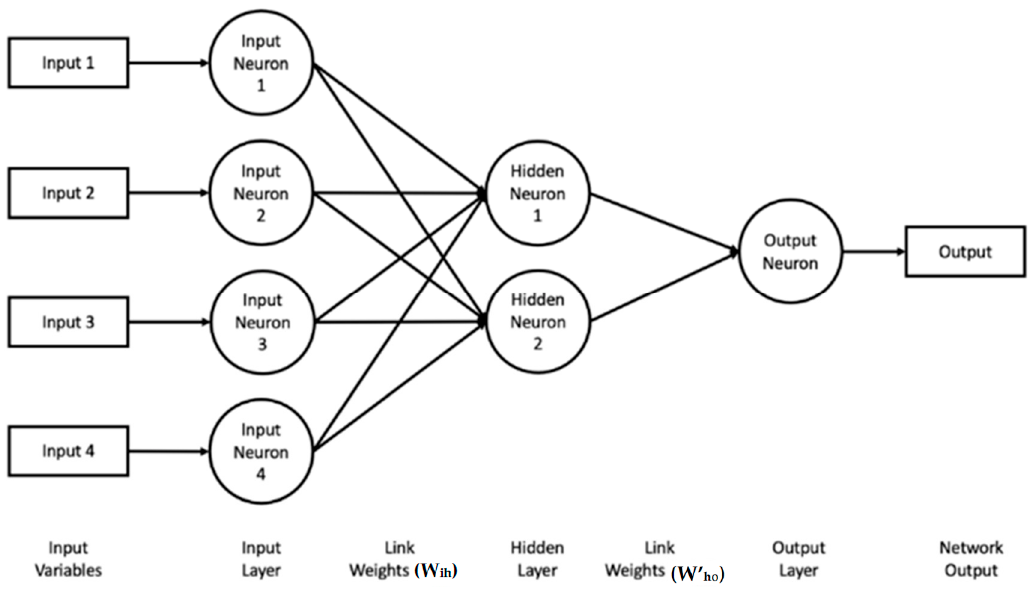
Figure 3. ANN Model Architecture .